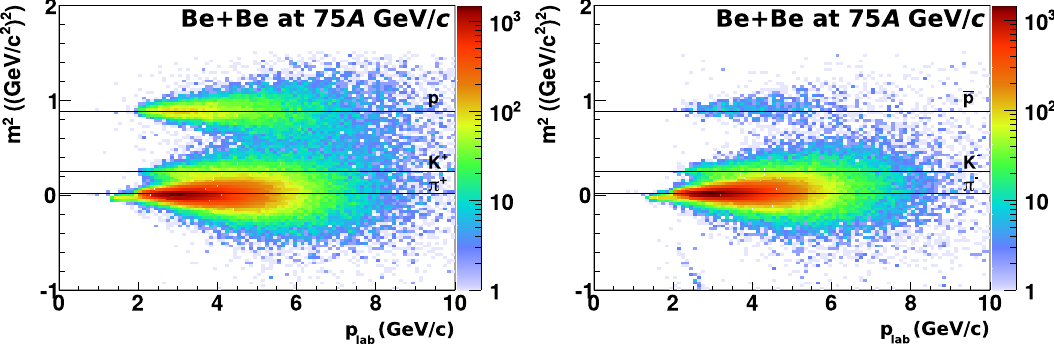
Fig. 10 Mass squared derived using time-of-flight measured by ToF-R (right) and ToF-L (left) versus laboratory momentum for particles produced in PSD selected Be+Be collisions at 75 A GeV / c (target inserted configuration). The lines show the expected mass squared values for different hadrons